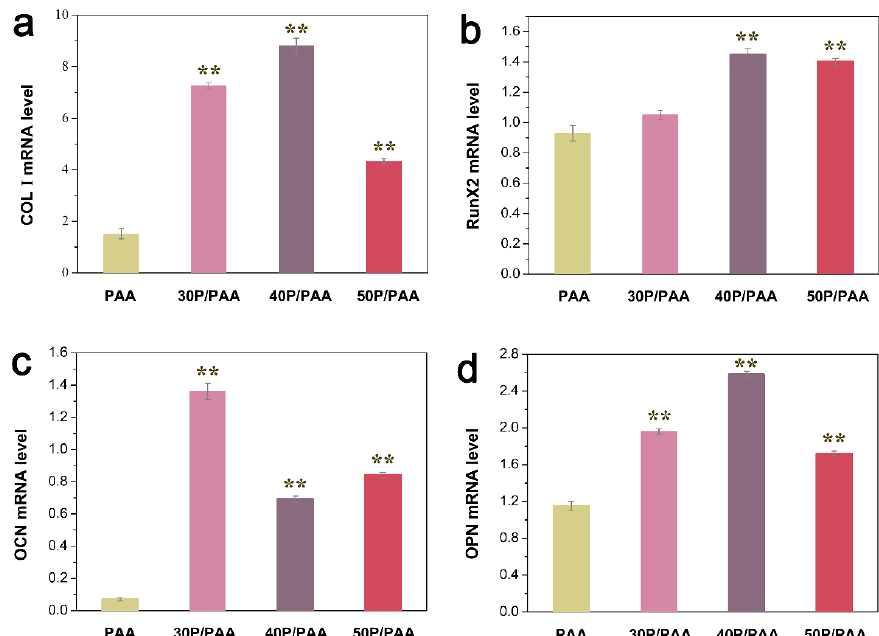
Figure 11. Relative mRNA expression of osteogenic differentiation-related genes in MSCs grown on PAA and the composites on day 7 measured by real-time PCR: ( a ) COL I, ( b ) RunX2, ( c ) OCN, ( d ) OPN. The mRNA levels of above using ACTIN as a reference. ** Significant difference compared with the PAA group ( p < 0.01).